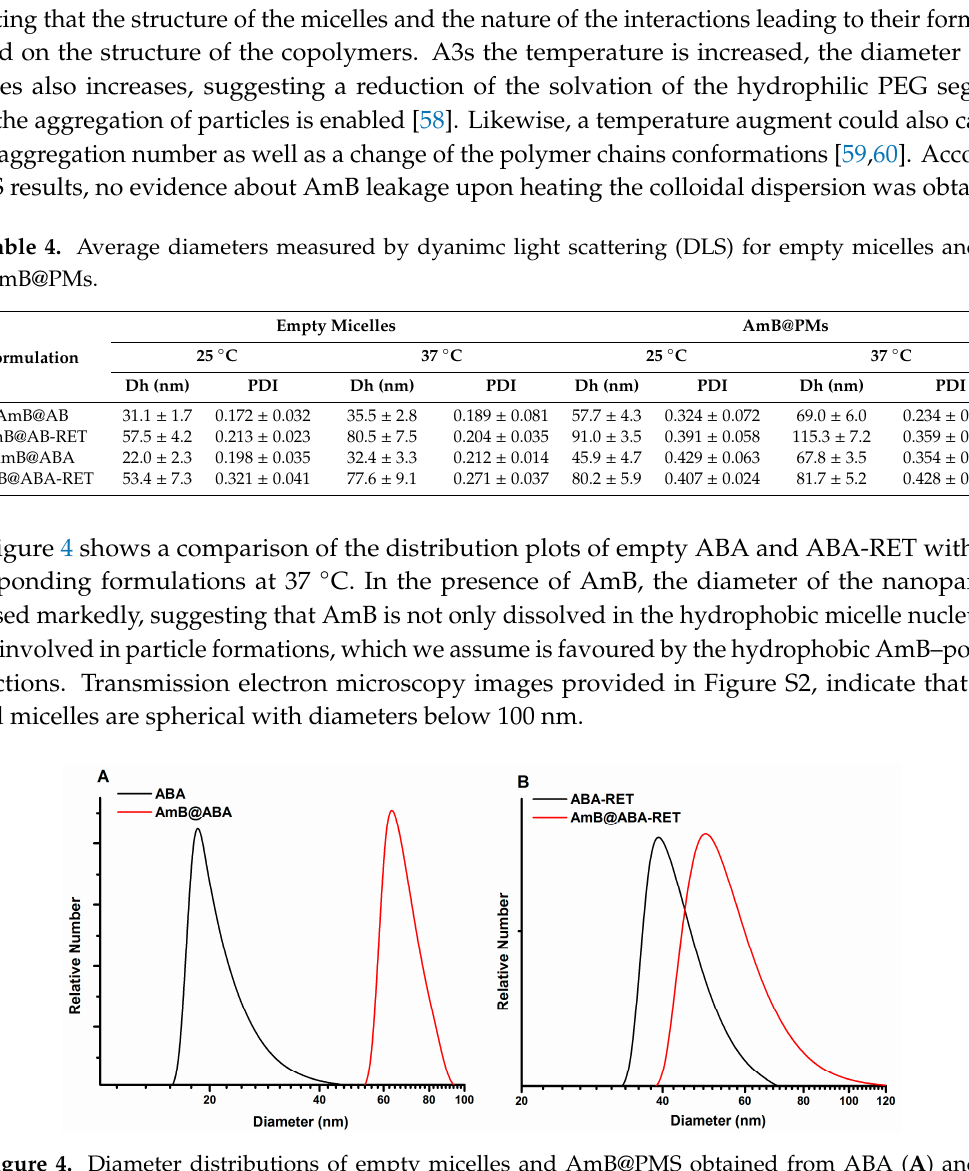
Table 3. Drug loading (DL) and encapsulation efficiency (EE) obtained by analysis by UV-vis the lyophilized formulations.